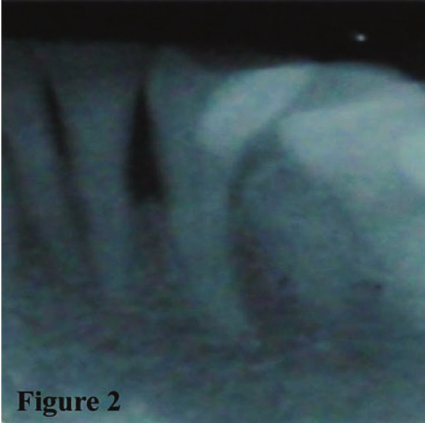
Figure 2: Radiograph showing horizontal bone loss between 32–34 regions.